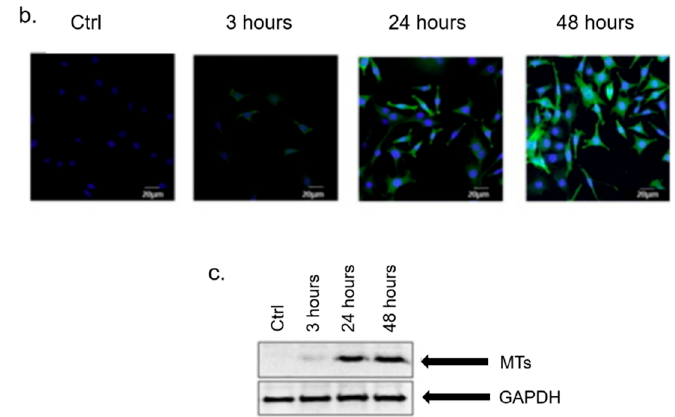
Figure 3. ( a ) Schematic representation mechanism of toxicity induced by AgNPs in cell. Reprinted/adapted with permission from [102], Copyright (2014) American Chemical Society ( b ) Representative images of Hela cell lines exposed to AgNPs at different time points and immunostained to detect metallothionein expression. Nuclei are stained by DAPI staining and metallothioneins with a primary anti-metallothioneins antibody coupled with a FITC-labeled secondary antibody. The expression of metallothioneins in cells is dependent on time. ( c ) Western blot analysis of metallothionein expression in HeLa cells treated with AgNPs. Adapted from [37] with permission from Elsevier, 2015.